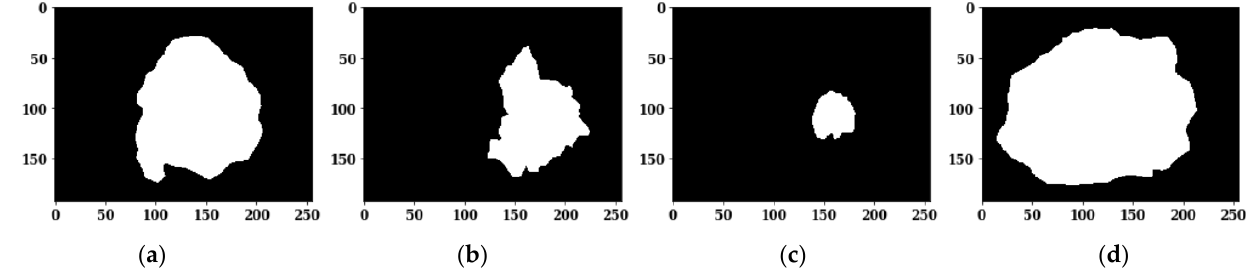
Figure 2. Ground Truth Masks for Respective Original Images: ( a ) Image 1; ( b ) Image 2; ( c ) Image 3; ( d ) Image 4.